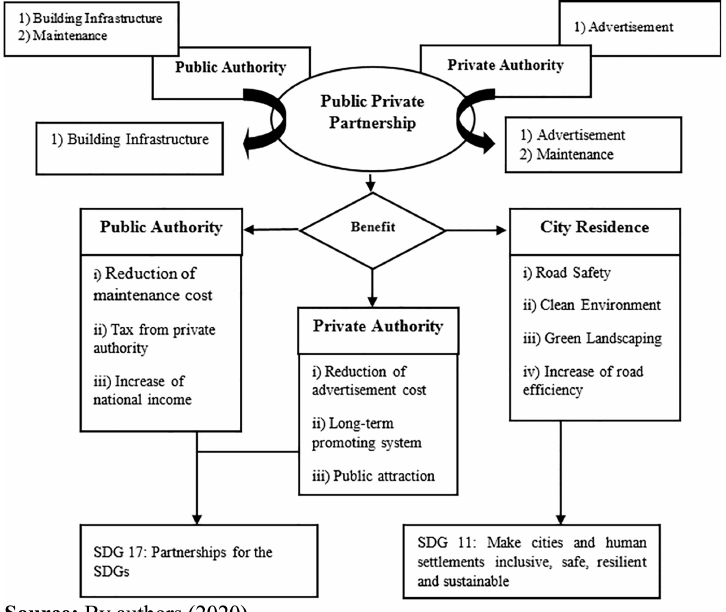
Figure 7. The local operational model of PPP in Khulna to achieve